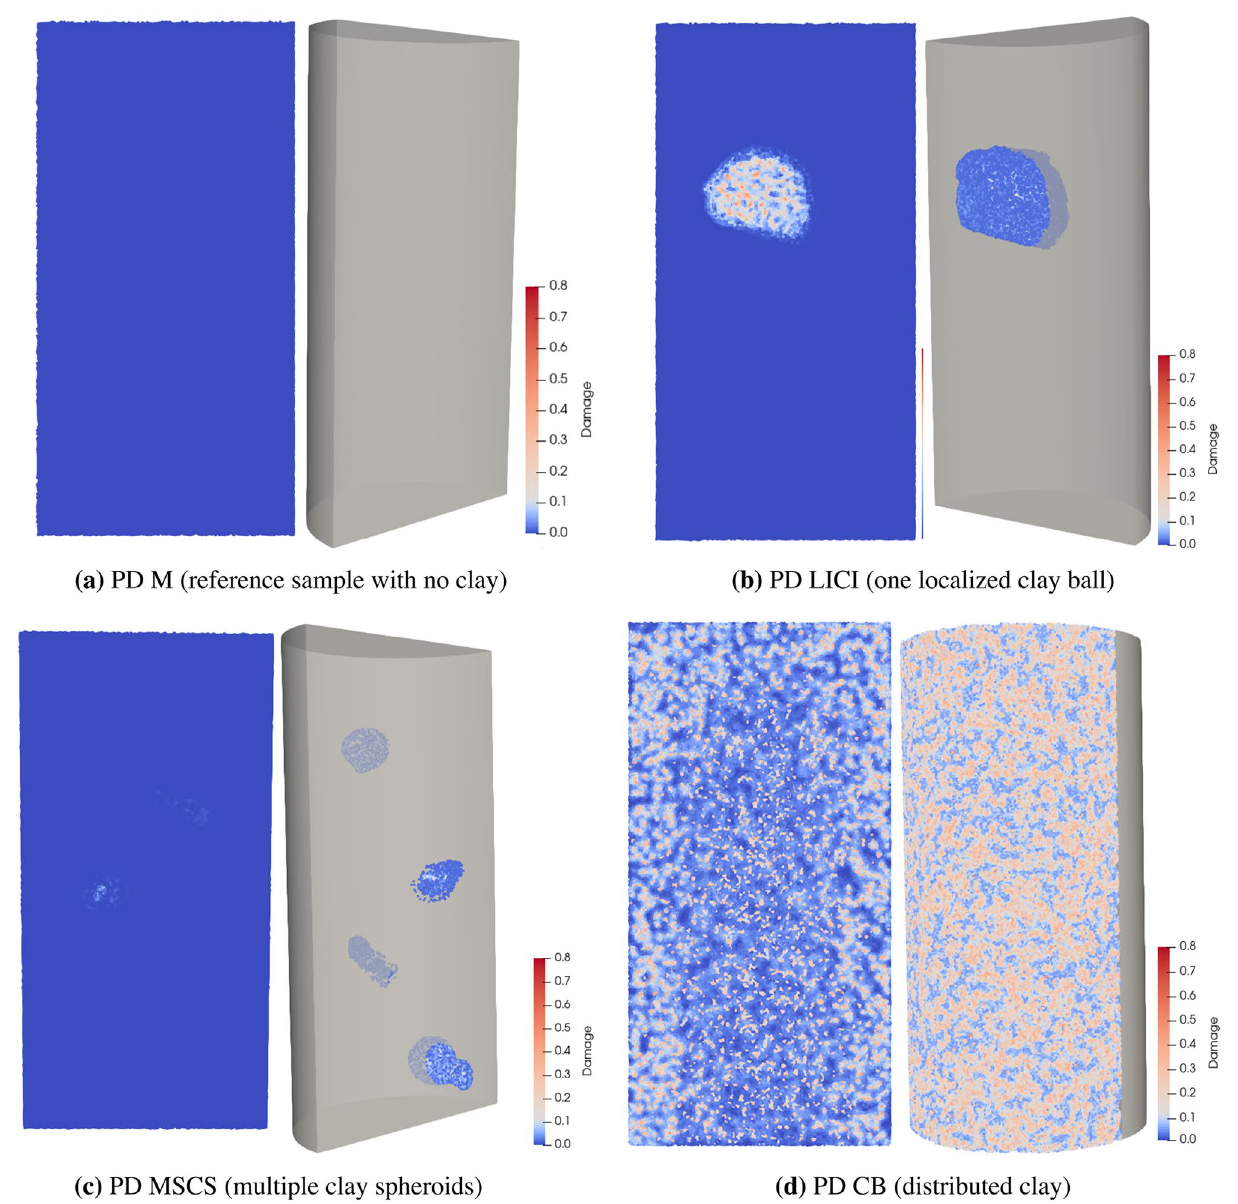
Figure 6. 2D image cross-sections from the center of the results of the PD simulations along the vertical axis and 3D visualizations of the interior. Damage is displayed above the threshold of 0.01 in the 3D images which emphasizes that damage is localized around the clay inclusions. The PD model results adequately reflect the experimental observations shown in Fig.